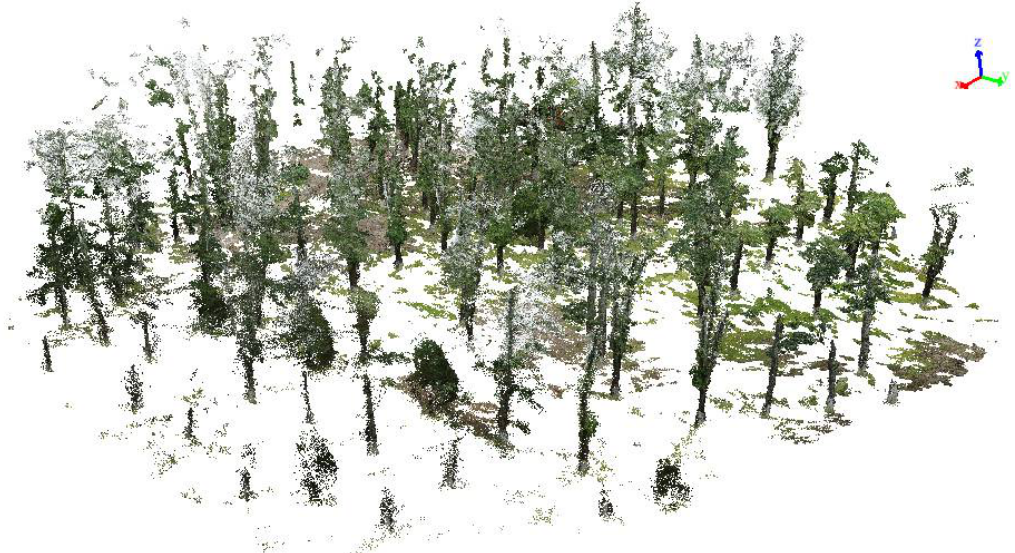
Figure 4. 3D point clouds of sample plot.